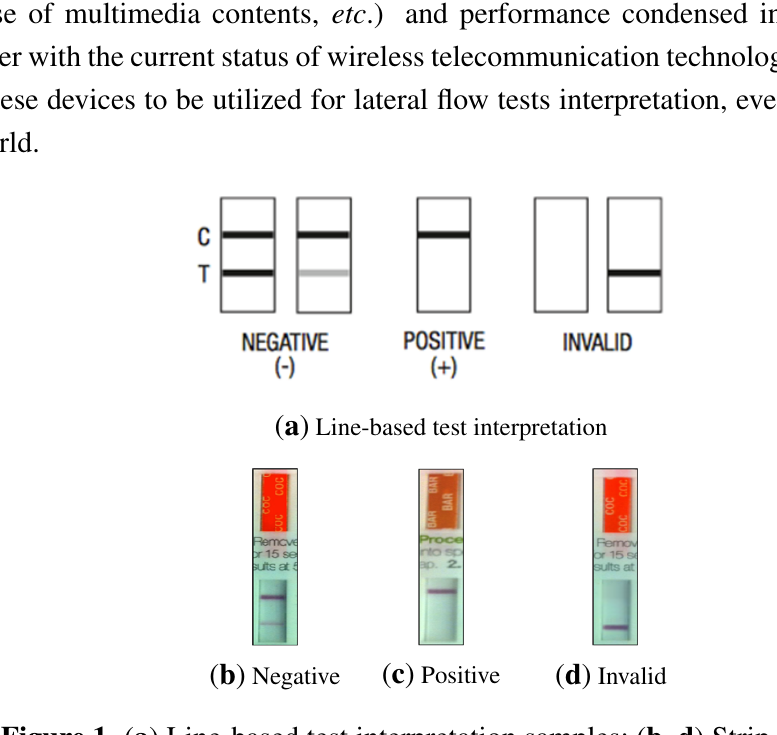
Figure 1. ( a ) Line-based test interpretation samples; ( b – d ) Strip samples.